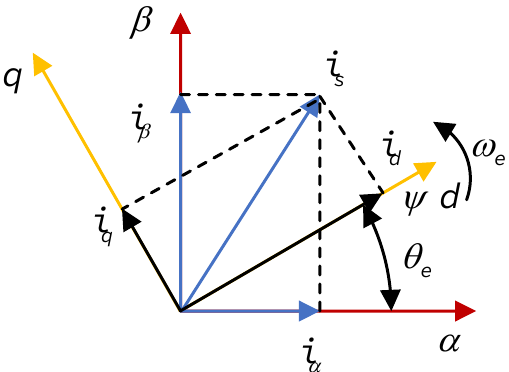
Figure 1. PMSM vector diagram under d-q coordinate and α - β